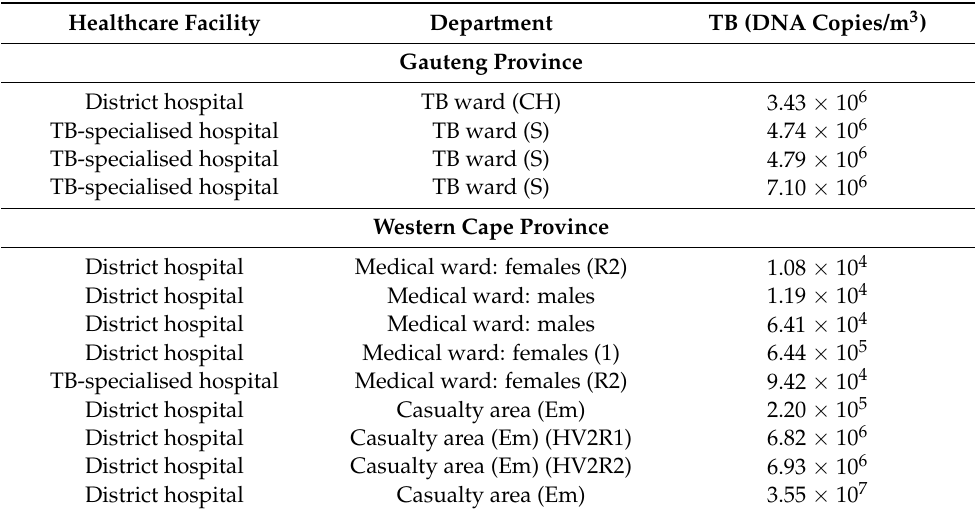
Table 3. Positive MTB samples categorised by province, facility type, and